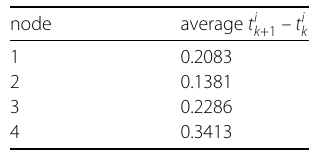
Table 1 Average interevent time for each node in the time interval [0,4] with the proposed control algorithm